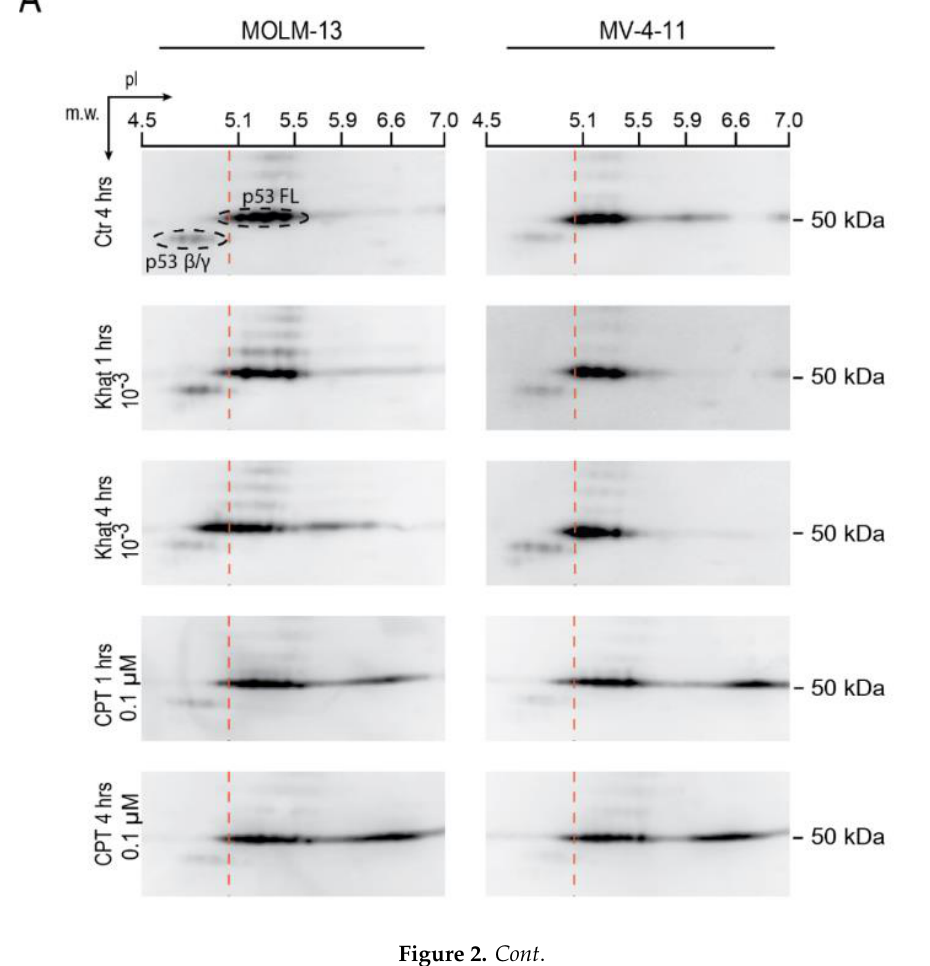
Figure 2. Khat induced post-translational modifications (PTMs) and altered p53 isoform patterns. ( A ) MOLM-13 and MV-4-11 were exposed to a khat-extract dilution of 10 – 3 and 0.1 μM CPT for 1 and 4 h, and analyzed for alterations in p53 isoform patterns using two-dimensional polyacrylamide gel electrophoresis (2D-PAGE) and Western blotting (original blots can be found at Figure S2). ( B ) Three